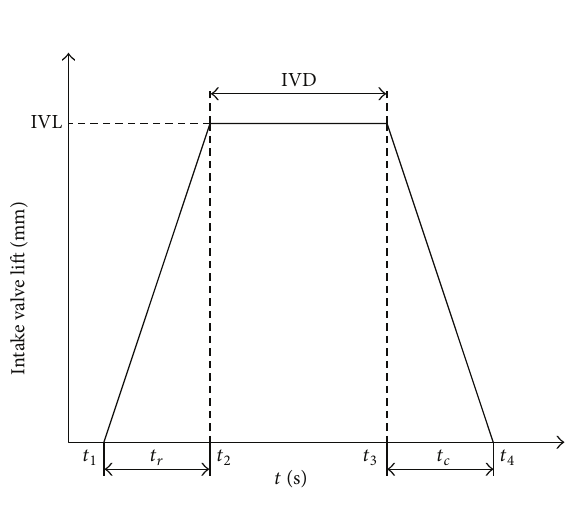
Figure 2: Valve lift